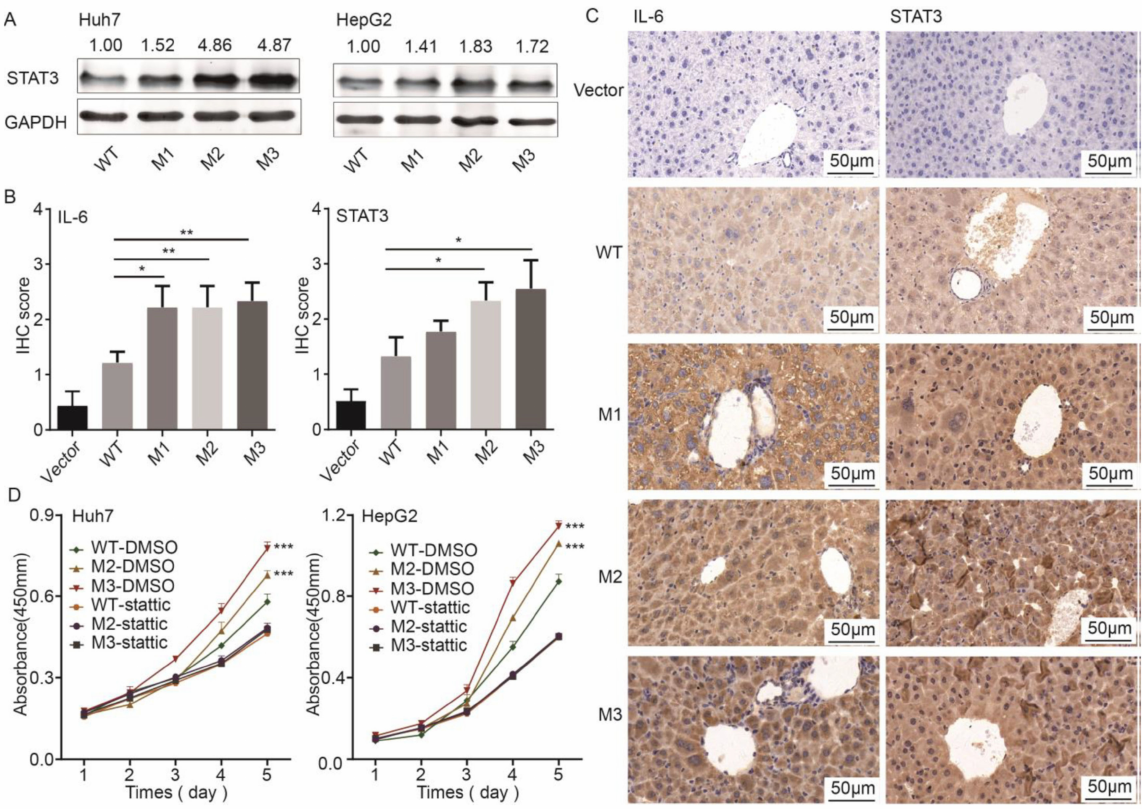
Figure 6. The roles of STAT3 in the preS1/preS2/S mutant-induced hepatocarcinogenesis. ( A ) The protein level of STAT3 was higher in Huh7 and HepG2 cells with ectopic expression of preS1/preS2/S mutants than in those with ectopic expression of the WT counterpart. ( B ) The histograms displaying the IHC scores of IL-6 and STAT3 in the liver tissues (vector group and WT group) and tissues adjacent to tumors (groups of preS1/preS2/S mutants) from SB mice. ( C ) Representative images for the IHC staining of IL-6 and STAT3 in adjacent liver tissues to tumors. ( D ) The effects of mutant HBV S proteins on the cell proliferation in Huh7 and HepG2 cells. In cells treated with 0.1% DMSO, M2 and M3 significantly increased the proliferation of HepG2 and Huh7 cells, compared with WT. In cells treated with 10 µ M Stattic, no significant difference was observed in the proliferation among cell expressing M2, M3, and WT. * p < 0.05, ** p < 0.005, *** p <